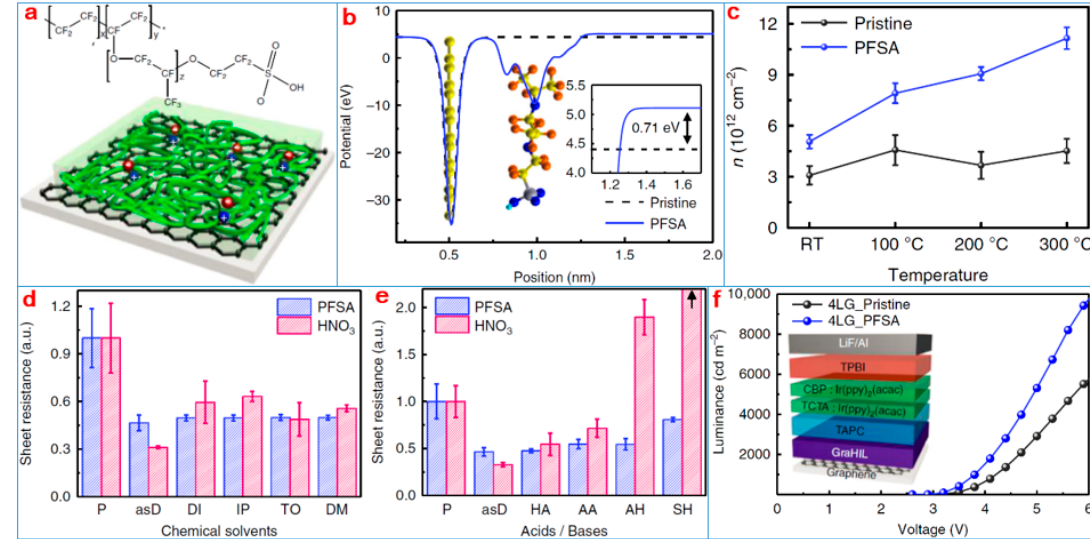
Figure 19. ( a ) Chemical structure of perfluorinated polymeric sulfonic acid (PFSA) and schematic Figure 19. drawings of graphene doped using PFSA (+: hole, − : electron). ( b ) Calculated electrostatic potential of the most stable configuration of PFSA-doped graphene (inset: difference in work function between pristine and PFSA-doped graphene). ( c ) Averaged n of thermally annealed pristine and PFSA-doped graphene with various T a calculated from Raman spectroscopy results. ( d ) Various solvent treatments and ( e ) acid and base treatments as a function of exposure time. ( f ) Luminance vs. voltage of green phosphorescent organic light-emitting diodes (OLEDs) with pristine and PFSA-doped graphene anodes (inset: schematic device structure of OLEDs) [146]. Copyright 2018, Springer